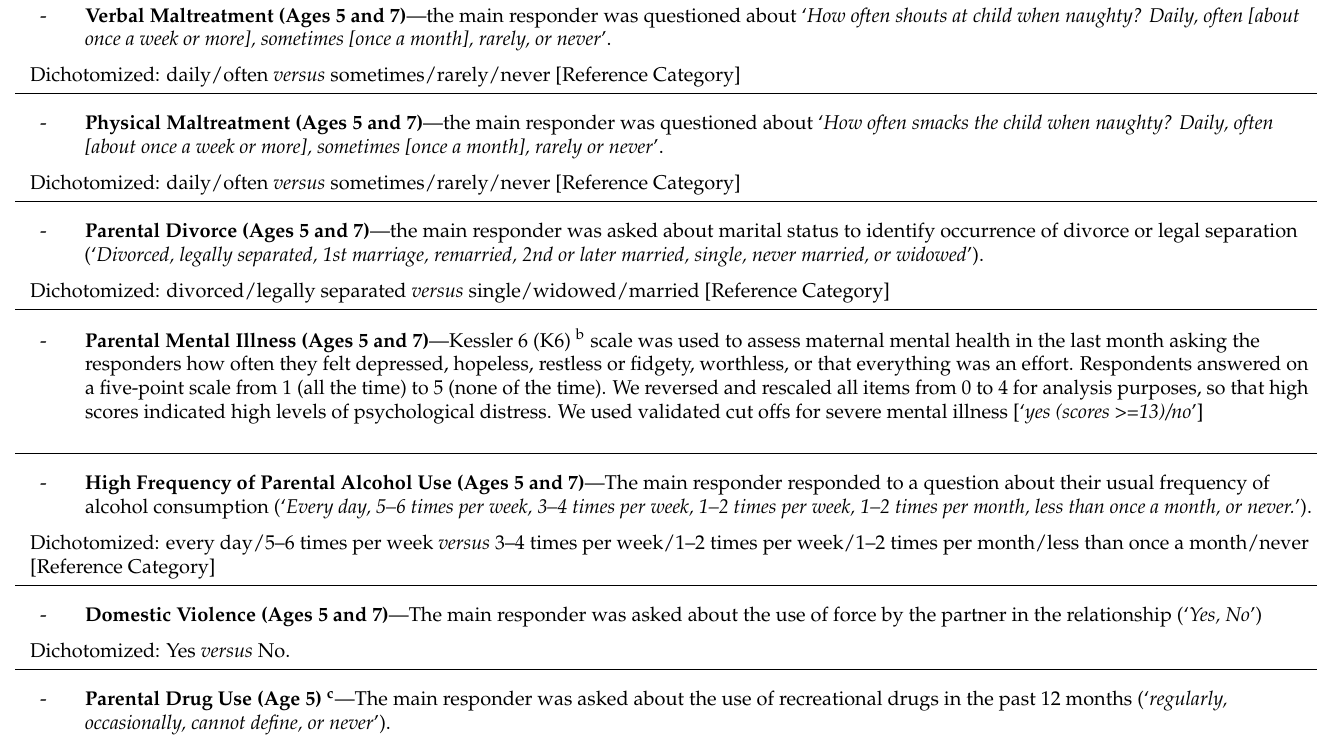
Table A1. Description of Adverse Childhood Experiences at Ages 5 and 7 a